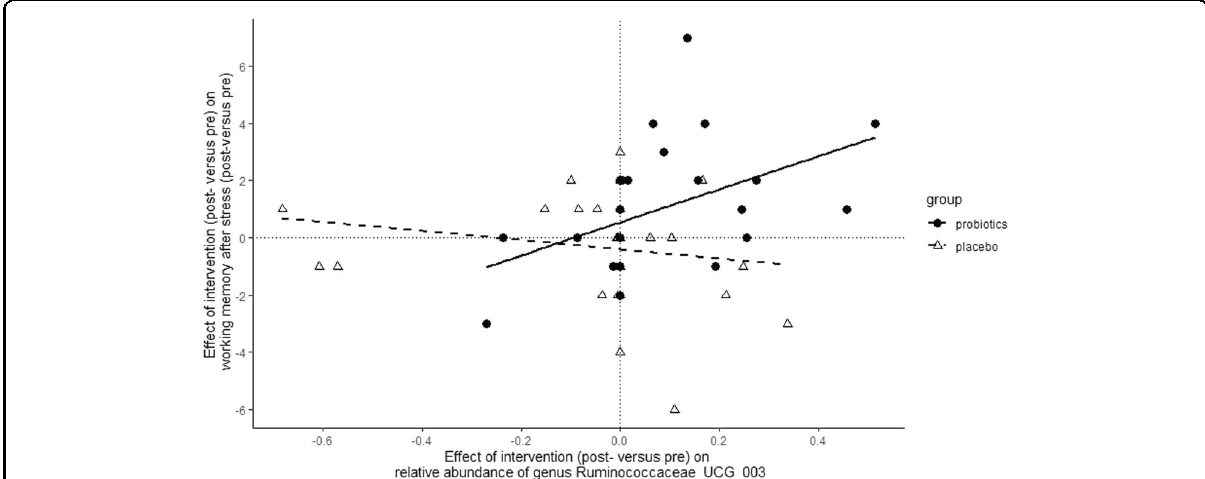
Fig. 4 Association between the intervention-induced change in the relative abundance of genus Ruminococcaceae_UCG-003 and intervention-induced protection of stress-induced working memory changes. Subjects with a higher increase in Ruminococcaceae_UCG-003 abundance after probiotics (right side of the x -axis) were also more protected from negative effects of stress on working memory after probiotics (upper side of the y